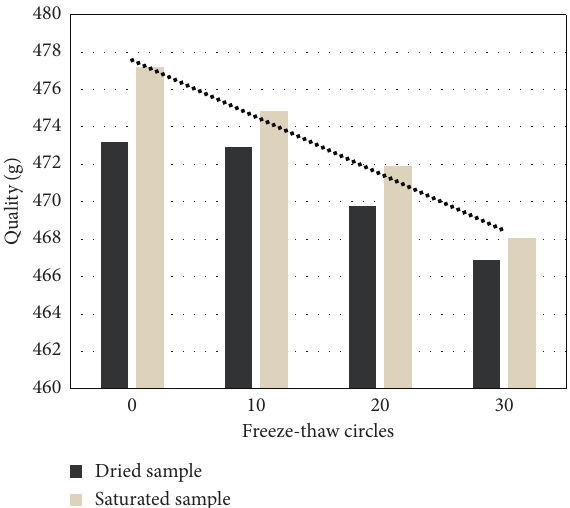
Figure 3: Histogram of relation between average weight of rock samples and freeze-thaw cycles.